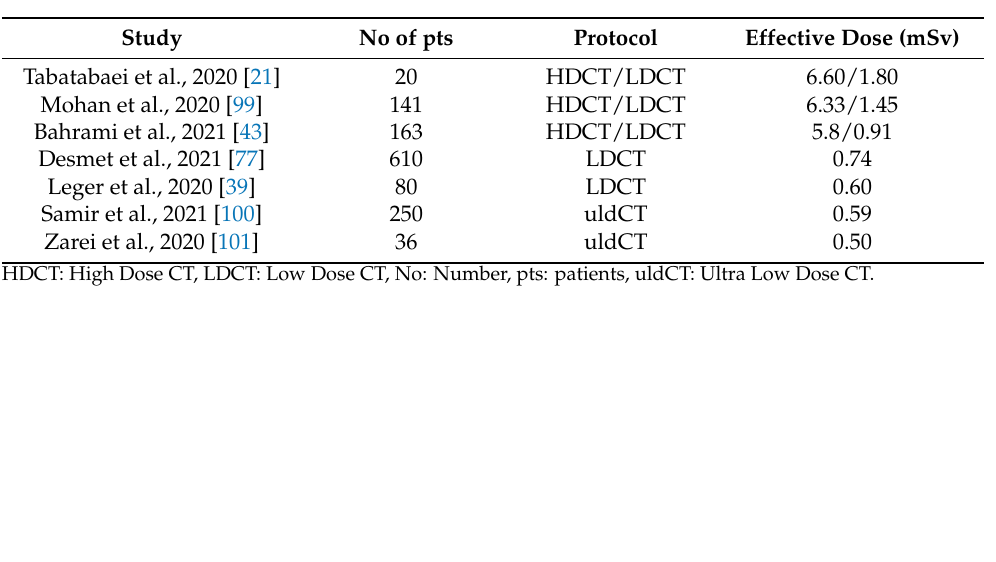
Table A1. Literature studies monitoring LDCT/uldCT protocol